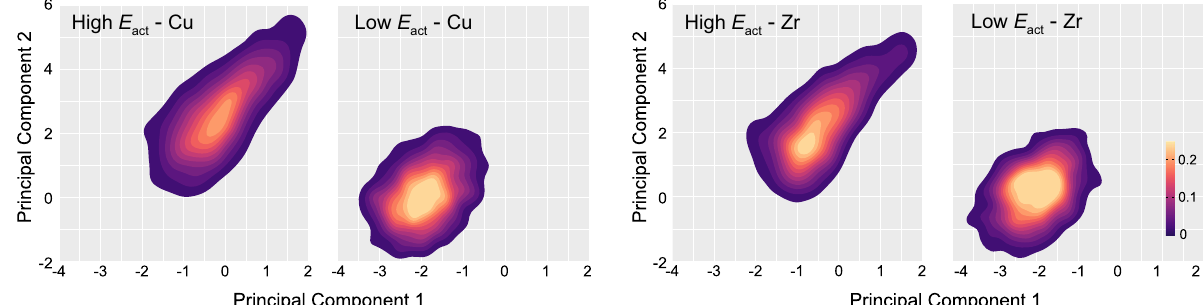
Fig. 5 Structural contrast between the high and low E act atoms. a Distribution of tetrahedron volume interstice V is and bond distance interstice d is-dist around representative Cu and Zr atoms with high E act = ~2.95 eV. The red and purple histograms show the spread of interstices in the coordination cluster (SRO) and that in the neighboring clusters (MRO), respectively. The SRO coordination clusters are also visualized in the inset, with the larger blue spheres for Zr and smaller orange spheres for Cu. The subscript “ dist ” in d is-dist means that the neighbors are determined by a cutoff distance rather than by the default Voronoi tessellation. b Distribution of V is and d is-dist around representative Cu and Zr atoms with low E act = ~0.71 eV. c Unsupervised principal component analysis (PCA) to reduce the original high- dimensional interstice feature space to a two-dimensional space. The color scale indicates the density level of the We then select typical hard and soft Cu (Zr) atoms and show the and MRO mean Std( d is-dist ) are the most important features in the L- distribution of tetrahedron volume interstice, V is , and bond E act and H- E act tasks, respectively (Fig. 4b). These two metrics are evaluating the average variation of the tetrahedron volume distance interstice, d is-dist , in their local environment to demon- interstice and bond distance interstice at the medium-range strate the inherent structural contrast between the hard and soft around an atom. This emphasizes the importance of local atoms. Typical atoms with high E act (~2.9 eV) and low E act (~0.7 eV) structure anisotropy, persisting to the medium-range, to the glass are selected, and the red and purple histograms show the spread property. For the L- E act task, MRO mean Std( V is ) stands out with a of interstices, V is and d is-dist , present in the coordination very high importance, and for the H- E act task, the feature polyhedron (SRO) and in the neighboring clusters (MRO), importances distribute more evenly. respectively (Fig. 5a and b). We fi nd that the V is and d is-dist